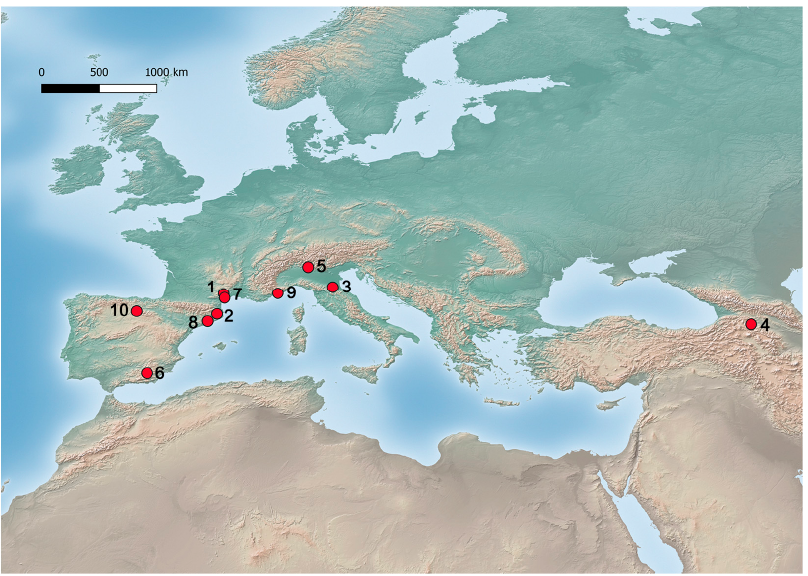
Figure 3. Lower Pleistocene sites where Celtis remains were reported (numbers in the figure correspond to ID numbers in Table 1) (map generated using QGIS version 3.4.13; Source: Natural Earth Data). Table 2. Middle Pleistocene sites where Celtis remains were reported (types of remains: wood char- coal (C), endocarp (E), leaves (L), pollen (P), wood (W)). Cultural Ad- ID Site Location Type scription